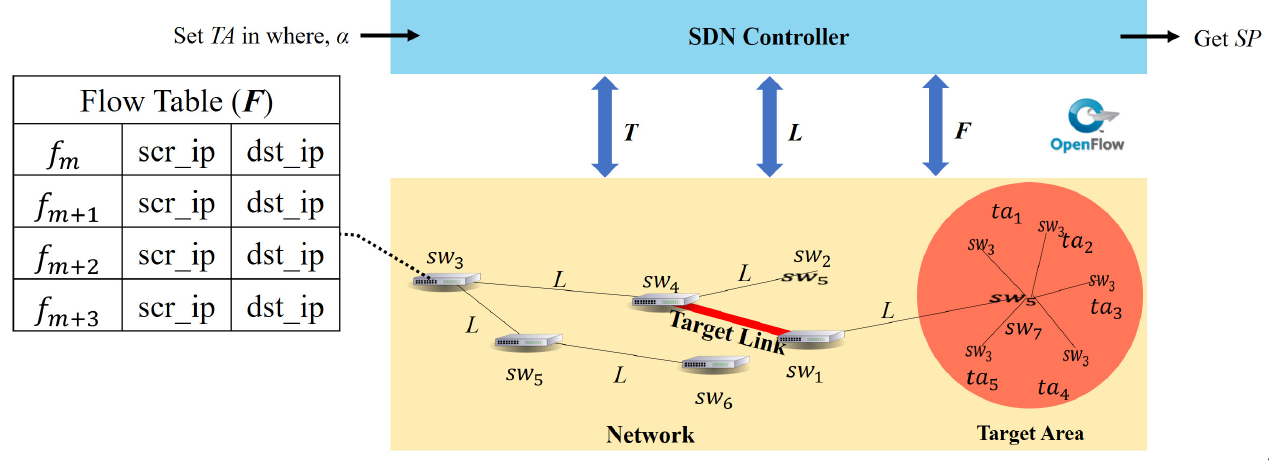
Figure 1. System model.